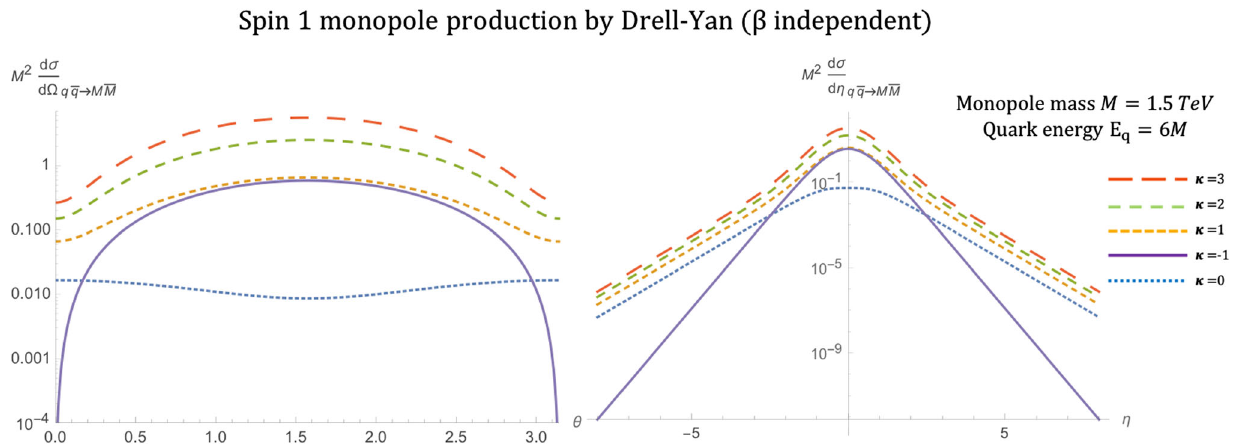
√ s qq = 2 E q , where E q = 6 M , and for pseudorapidity η (right) at various values of the parameter κ . The case κ = 1 represents the SM expectation for the DY pair production of spin-1 W ± bosons